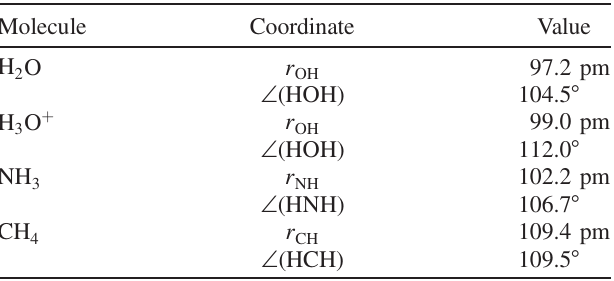
TABLE IV. Optimized geometries of H 2 O, H 3 O þ , NH 3 , and CH 4 given in internal coordinates, i.e., bonds lengths and angles.